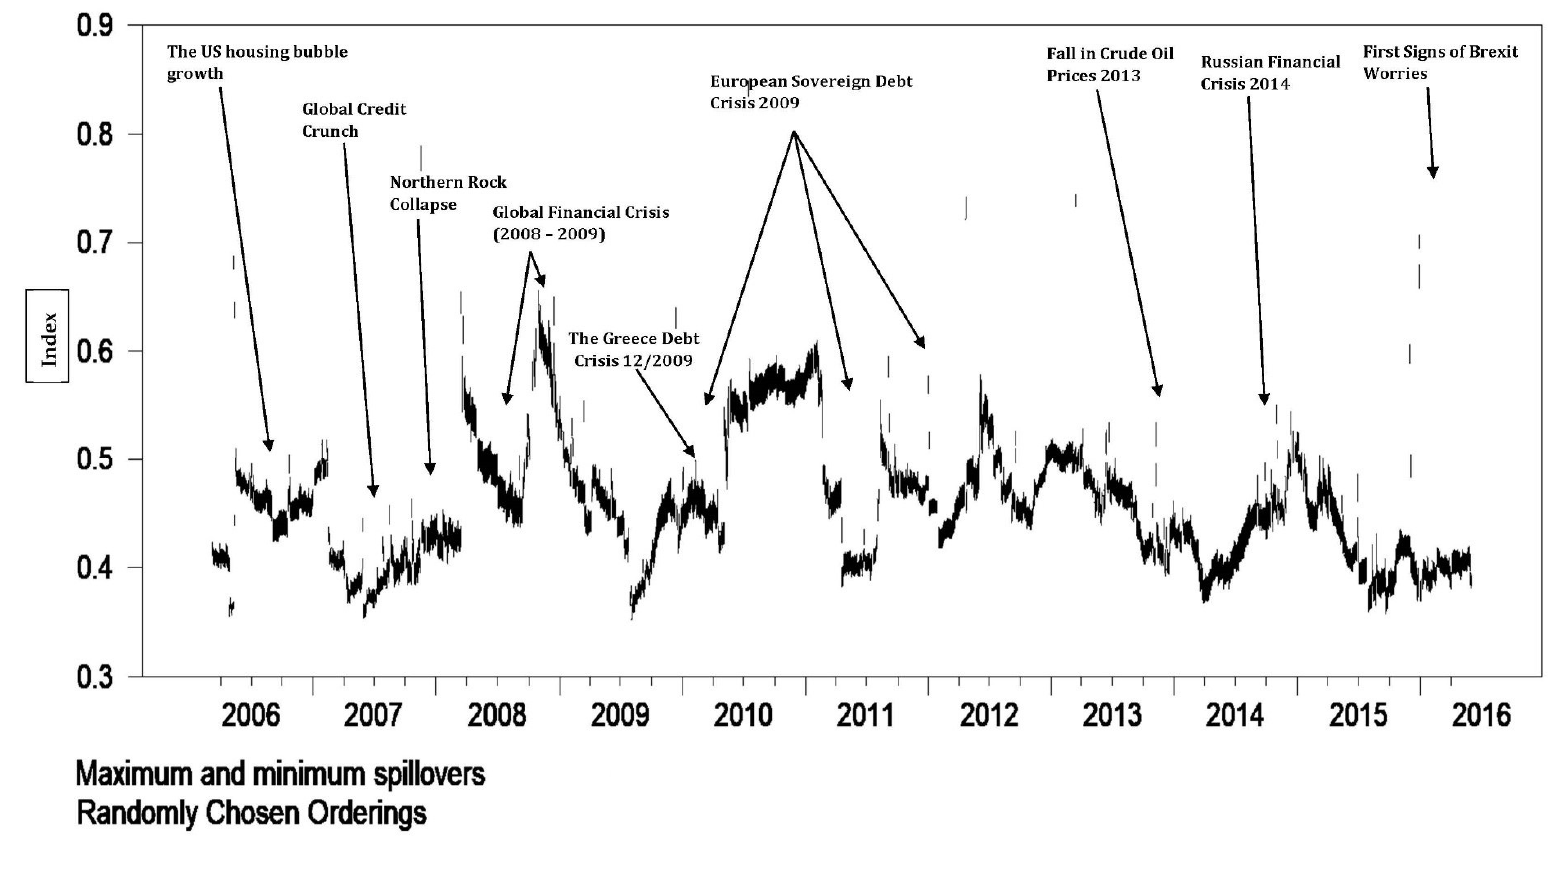
Figure 4. Maximum and minimum spillovers. Global foreign exchange markets (2005–2016).